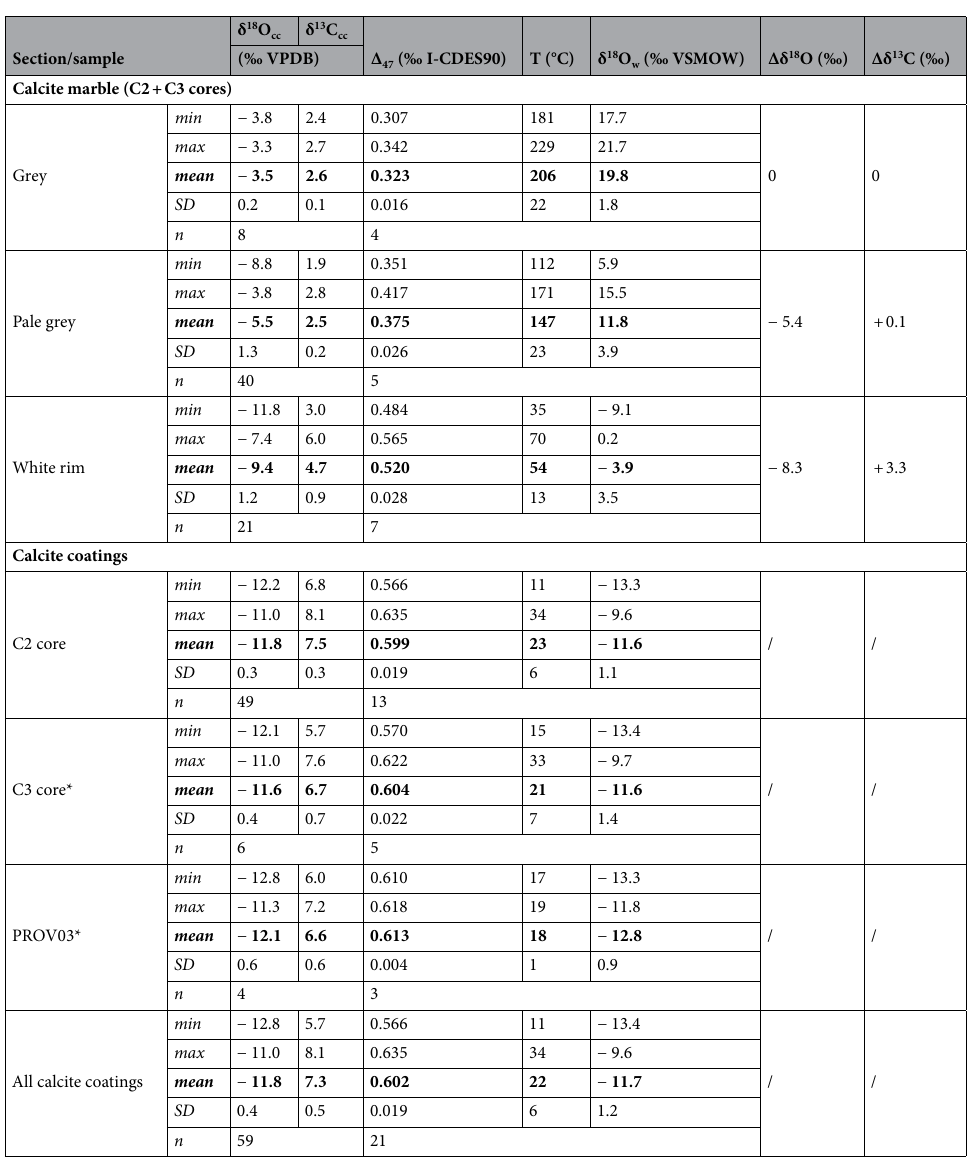
Table 1. Summary statistics of the stable isotope composition of wall bedrock and calcite coatings from Provalata Cave. *For samples with available fluid inclusion data, measured δ 18 O w is used. Full dataset is available in the Supplementary Table